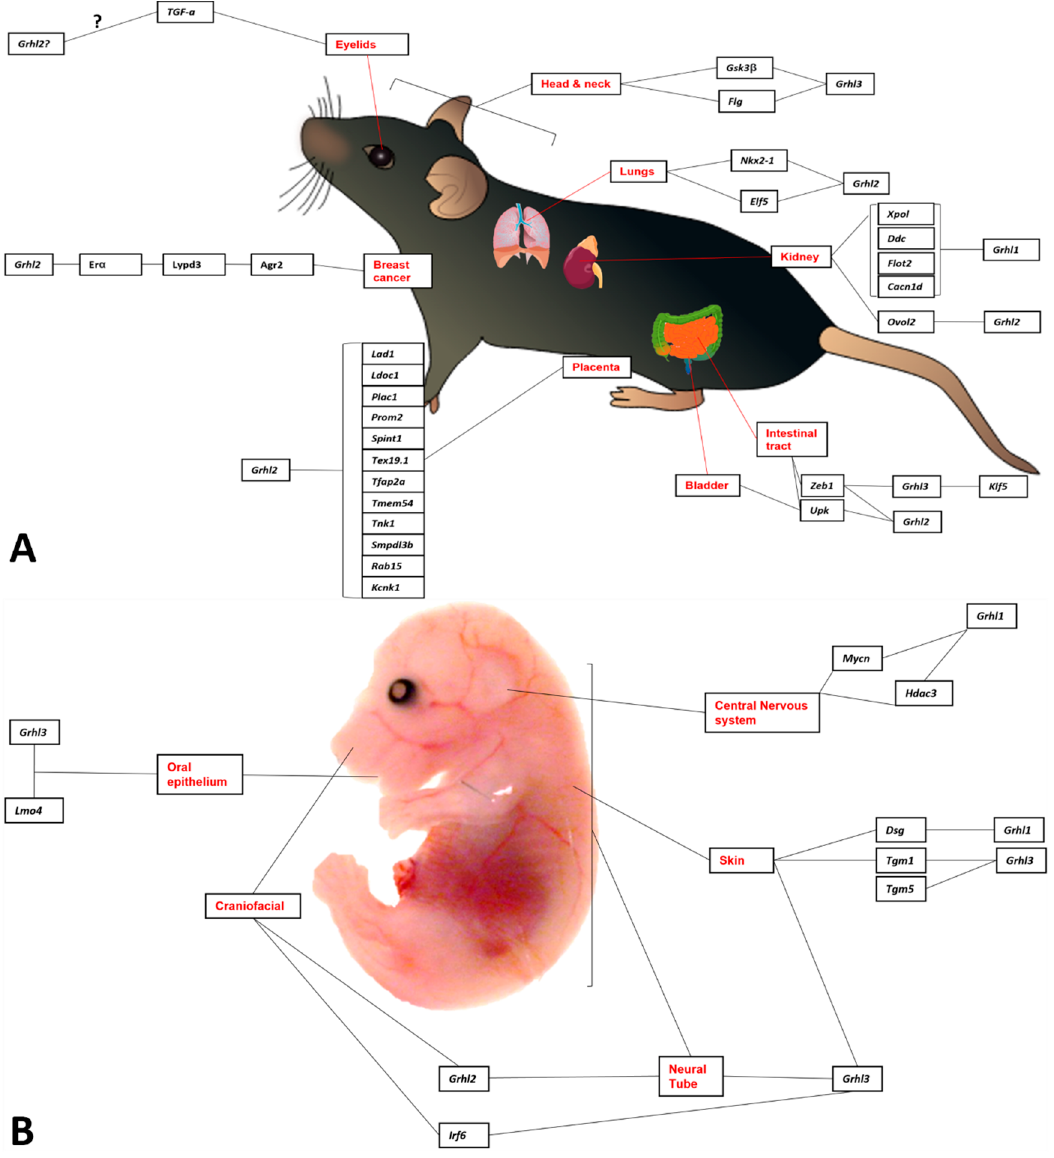
Figure 2. Grainyhead-like target genes in embryonic and adult murine tissue. ( A ) In adult mice and mouse-derived cell lines Grhl2 binds to Elf5 in embryonic lung tissue and Nkx2-1 in the lung epithelium specifically. In the kidney, Ovol2 is positively regulated by Grhl2, whilst in the Bladder Grhl2 regulates Upk in the differentiation of umbrella cells aiding in barrier formation. Grhl2 also regulates TGF-a in eyelid development. A number of genes have been found to have been regulated by Grhl2 in the placenta, including Lad1, Ldoc1, Plac1, Prom2, Spint1, Tex19.1 Tfap2a, Tmem54, Tnk1, Smpdl3b, Rab15 and Kcnk1, although the functions of these interactions remain unclear. In the kidney, Grhl1 regulated cacna1d, Ddc, Flot2 and Xpol in tumourigenesis. Similarly, Grhl2 regulates a number of genes in breast cancer including Er α and ZEB1 in the context of epithelial-mesenchymal transition. Grhl3 regulates Upk in the bladder and ZEB1 in the gastro-intestinal tract, whilst itself regulated by Klfs in the gut. ( B ) Mouse embryo target genes. Grhl1 regulates Dsg in hair development and Mycn and Hdac2 in the promotion of tumourigenic properties in neuroblastoma lines. Grhl3 controls TGM1/5 in skin barrier defects and Lmo4 in the oral epithelium.